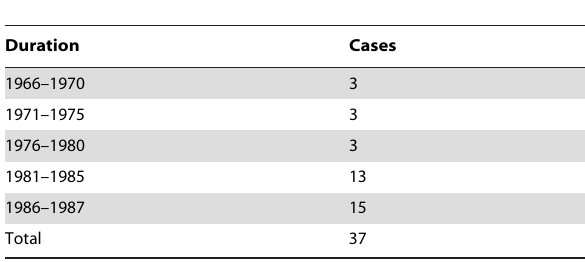
Table 3 Investigation of human cystic echinococcosis surgical cases determined by questionnaire in Yuanhuchun Community and Ershilidian Community, Hutubi County, Xinjiang, China.